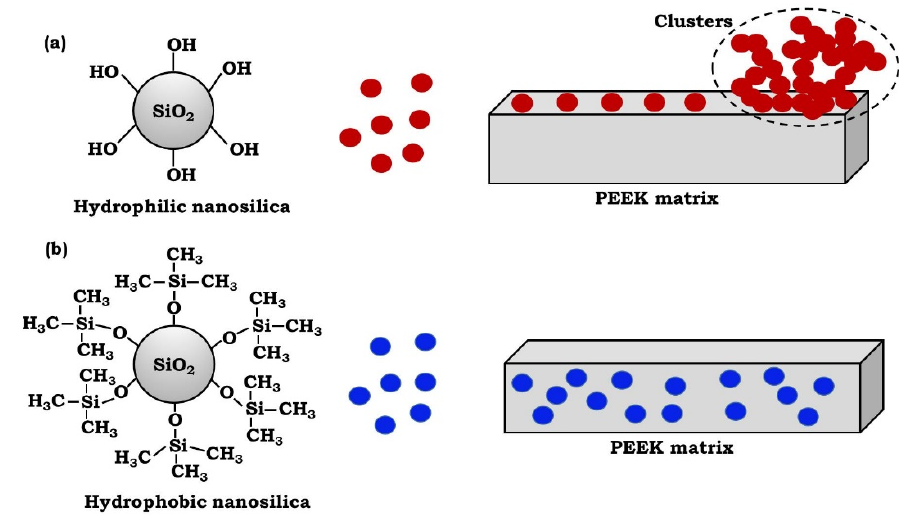
Figure 4. Schematic representation of the degree of dispersion and distribution of nano-SiO 2 par- ticles in the PEEK polymer matrix. ( a ) The hydrophilic nano-SiO 2 particles are fused together into clusters with an irregular, chain-like geometry. ( b ) The hydrophobic nano-SiO 2 particles exhibit good dispersion and distribution within the hydrophobic PEEK matrix.